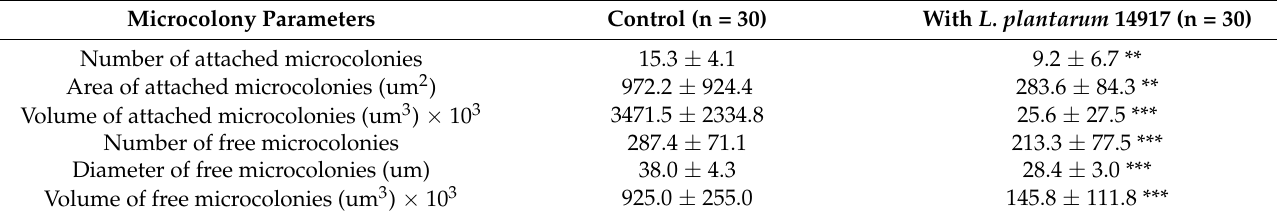
Figure 4. Changes in multispecies biofilm 3D structure caused by L. plantarum 14917. Biofilms were formed by C. albicans and S. mutans only (control) and treated with L. plantarum 14917 in 1% sucrose condition and visualized via two-photon laser confocal microscope at 72 h. Amira software was used to reconstruct the images as 3D structures, to visualize bacterial channels (green), EPS channels (red), and the bacteria/EPS overlay. ( A ) Biofilm structure. The layer distribution of the biofilms indicating that the biofilms grown in the control group were much thicker than those of the treatment group. ( B ) Biomass formed by bacteria. ( C ) Biomass formed by EPSs. ( D ) Bacteria co-localized by EPSs. Biofilm parameters were calculated using data from three biofilms formed by C. albicans and S. mutans isolated from three ECC children. For each biofilm, 10 randomly selected points of biofilms were visualized. Table 2. Quantitative assessment of microcolonies in multispecies